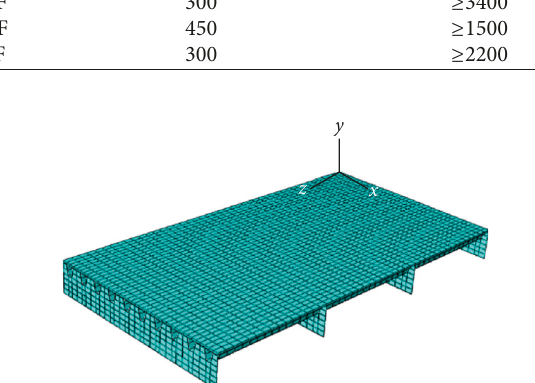
Figure 3: Structural model of steel bridge deck